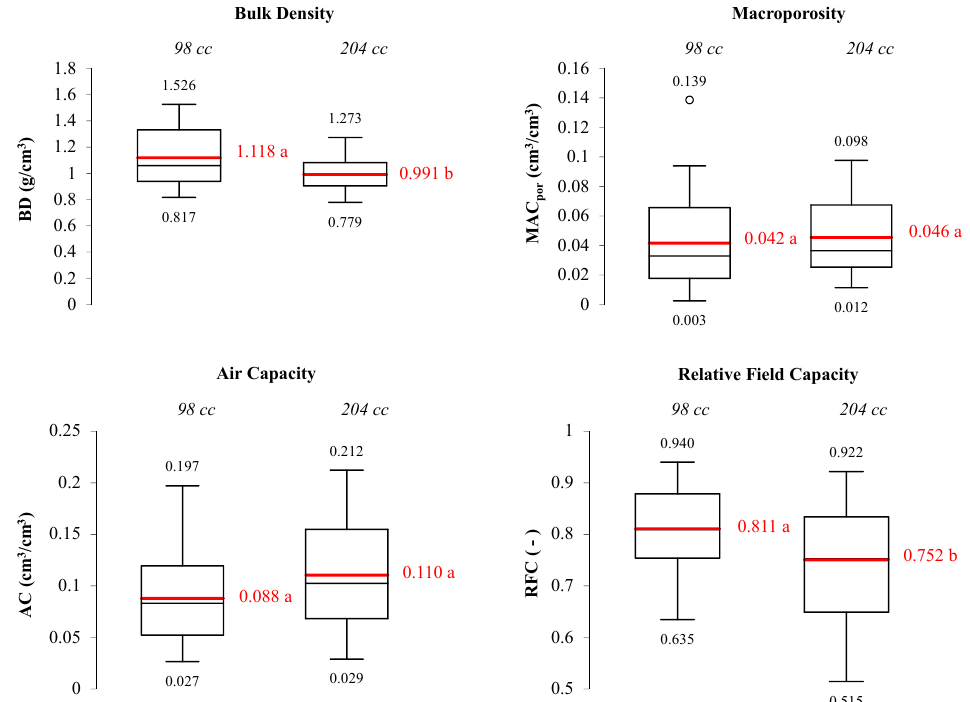
Figure 4. Box plots of considered soil physical quality (SPQ) indicators obtained using the soil sampler of 98 and 204 cm 3 . Note that each box takes into account of the full available dataset (Foggia and Matera, under CT and NT). The thick red line on each box represents the mean value (thin black line, the median), and circles represent outliers; min and max values were also showed. Means labeled by the same letter are not significantly different, according to a two-tailed t-test ( P = 0.05).